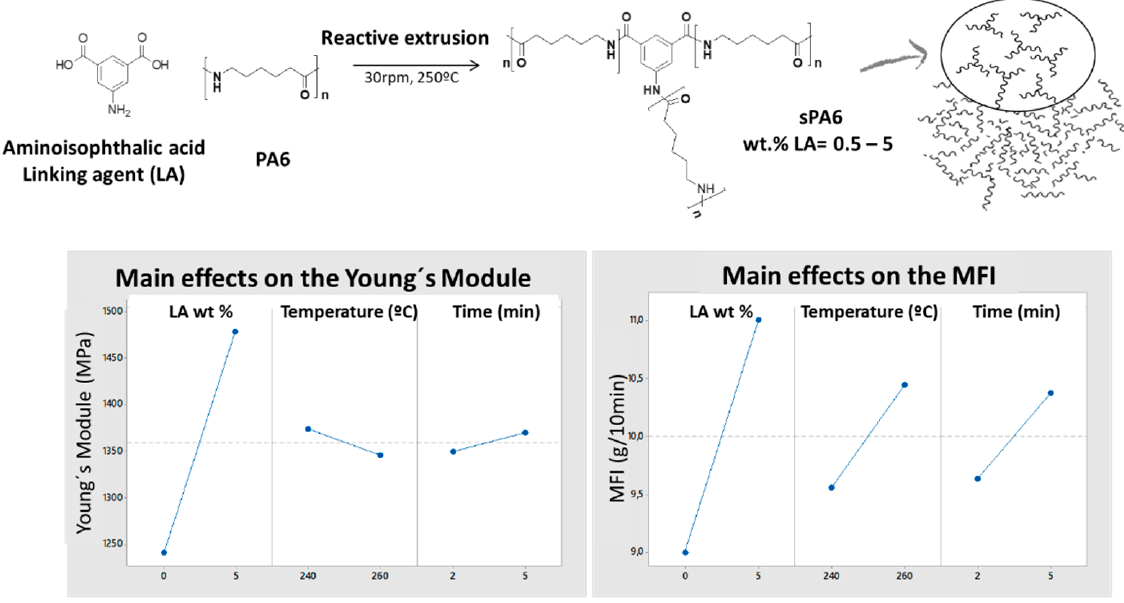
Figure 1. ( a ) Representation of the synthesis process of 3-arm star-type polyamides. ( b ) Choosing the main experimental parameters conditioning the fluidity and mechanical properties of sPA6 by